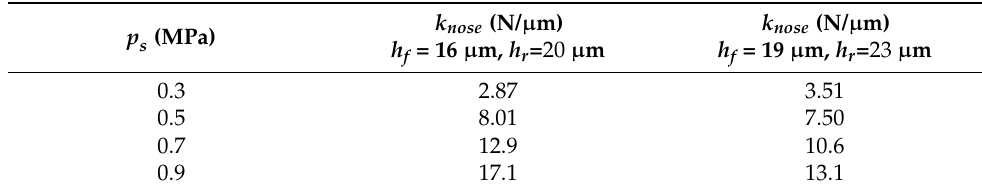
Table 7. Radial stiffness on the nose at different supply pressures and radial clearances, calculated at small eccentricity (1 µ m).